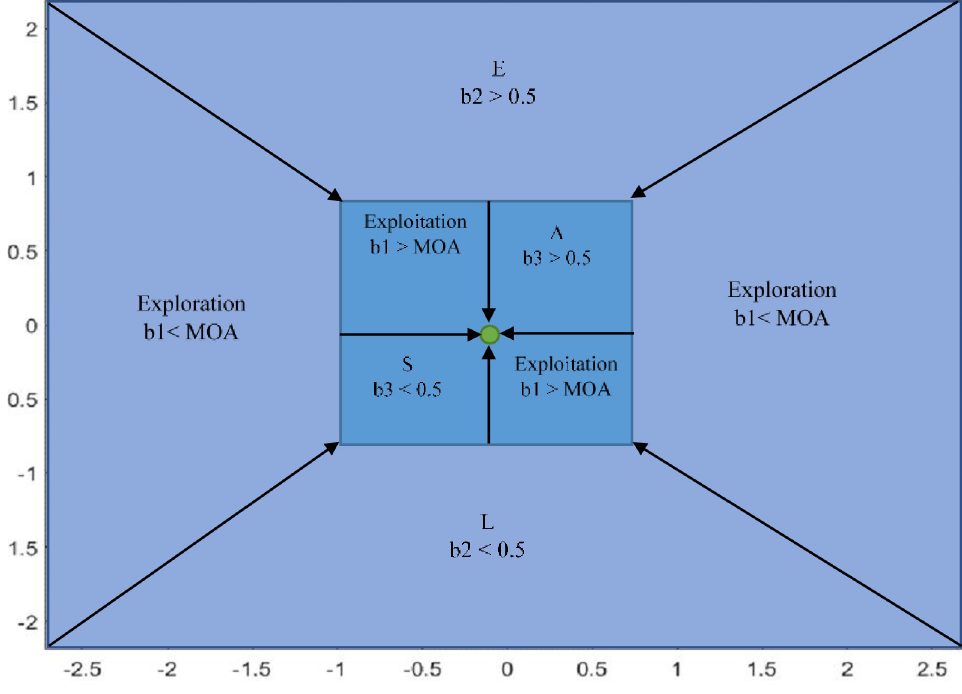
Fig 2. Exploration and exploitation phases of